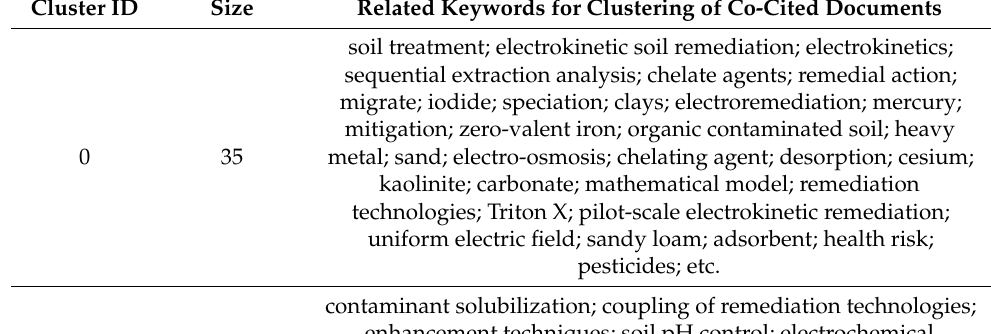
Table 5. Clustering information of co-cited keywords in the literature. Cluster ID Size Related Keywords for Clustering of Co-Cited